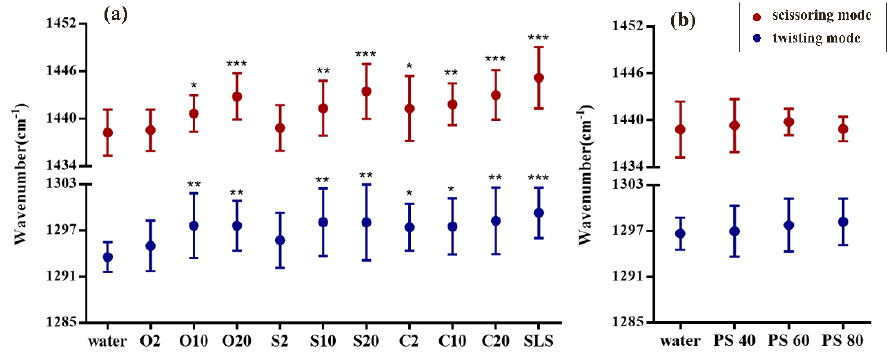
Figure 4. Lipid signals of CH 2 twisting and scissoring mode for analyzing ( a ) PEG alkyl ethers treated SC and ( b ) PEG sorbitan esters treated SC. Mean ± SD, n = 18. * p < 0.05; ** p < 0.01; *** p < 0.001.